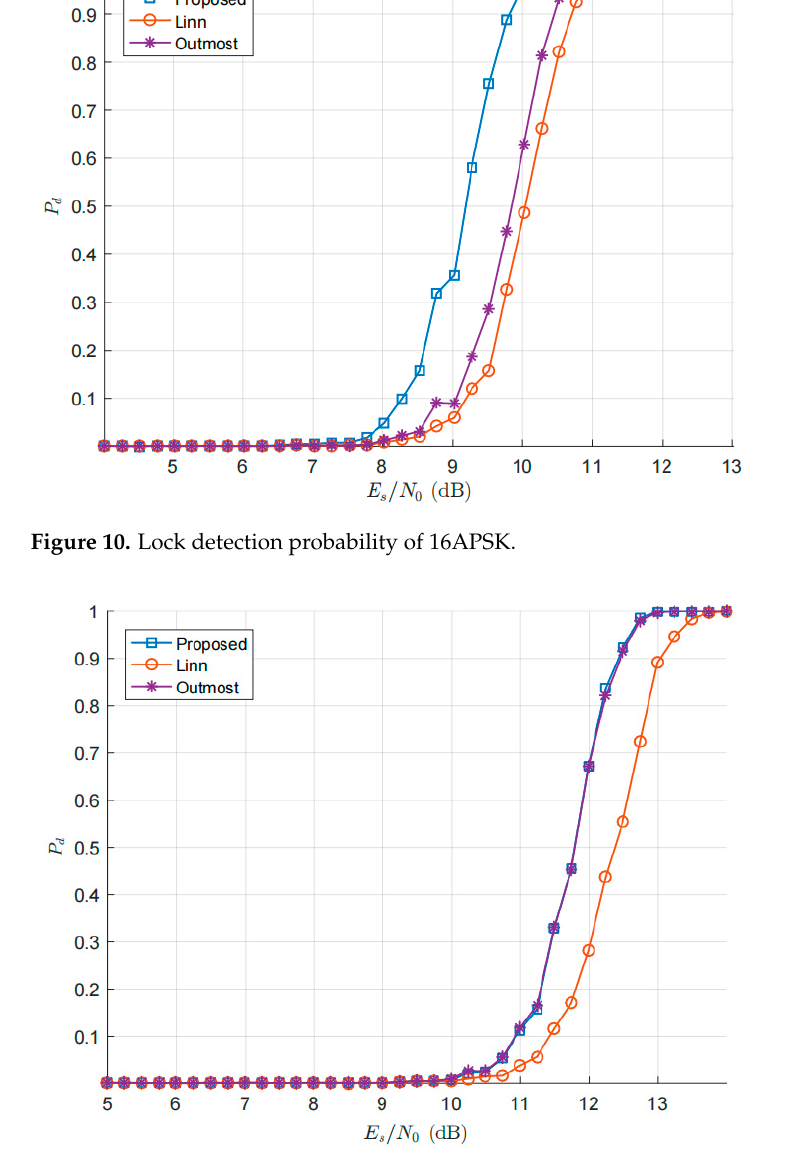
Figure 11. Lock detection probability of 32APSK.